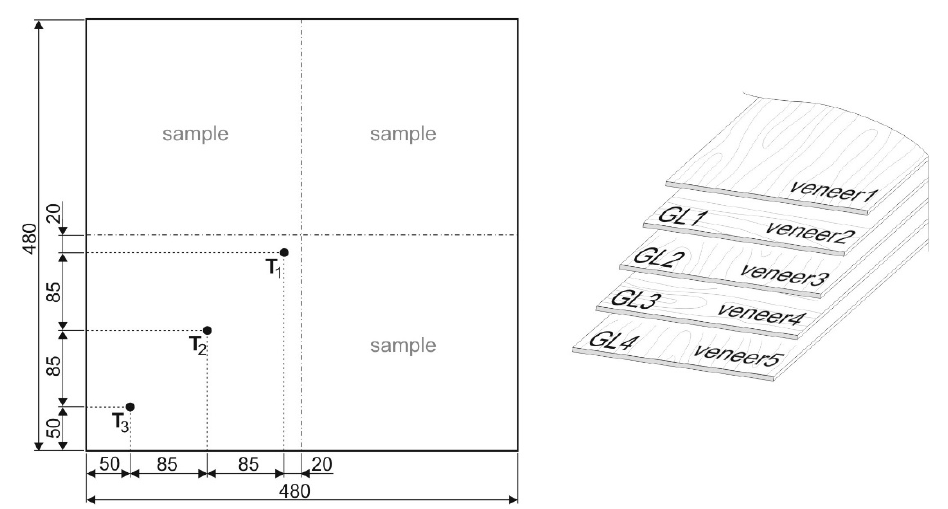
Figure 1. Composing veneers with adhesive mixture applied with fixed sensor to monitor the temperature flow inside the board during the plywood pressing process.